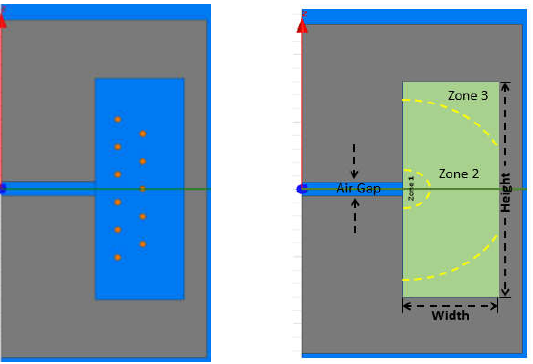
Figure 7. Axisymmetric representation of an RM6 core for the magnetostatic analysis. The case with 11 spaced conductors carrying a current of 1 A (NI/lg = 22 × 103 A/m) and the zone divisions for the representation of the accuracy of the calculated fields.